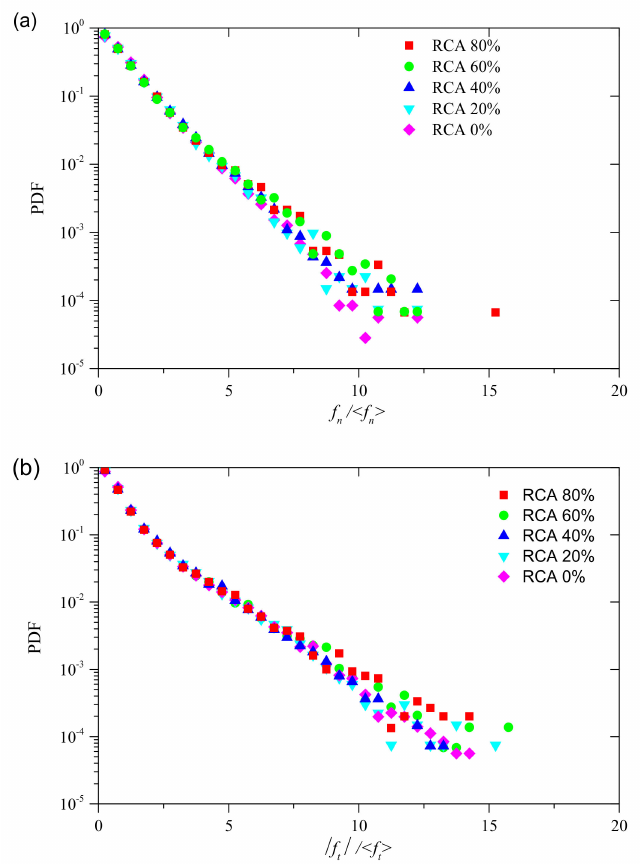
Figure 15. PDFs of samples with different RCA contents: ( a ) normalized normal contact force; and ( b ) normalized shear contact